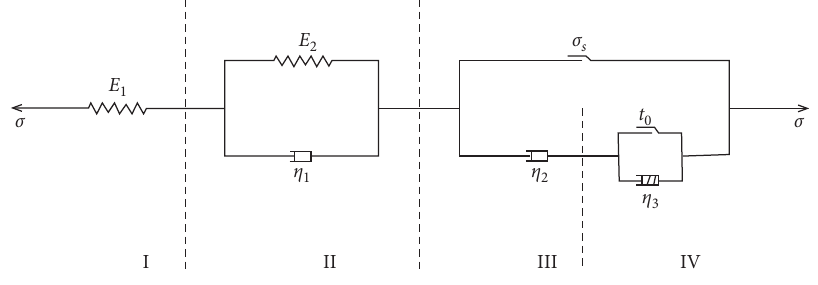
Figure 3: Modified visco-elastoplastic model.